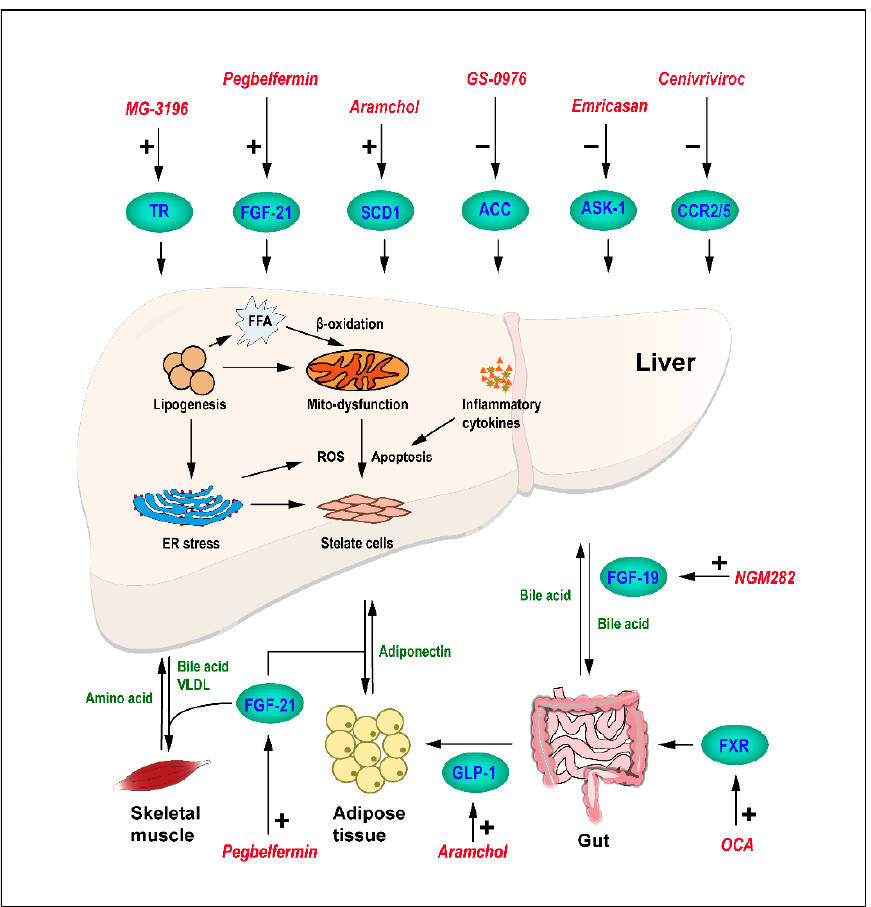
Figure 1. Representative therapeutic methods in the complex pathophysiology of NASH, which involved a variety of organs, tissues, and cells. Signals marked in green are protective against NASH, and those marked in red are current clinical trial drugs that ameliorated NASH as agonists/inhibi- tors (+/ − ) of various receptors marked in blue. Abbreviations: TR, thyroid hormone receptor; FGF, fibroblast growth factor; SCD1, stearoyl-CoA desaturase; ACC, acetyl-CoA carboxylase; ASK1, apoptosis signaling kinase 1; GLP-1, glucagon-like peptide 1; FXR, farnesoid X nuclear receptor; FFA, free fatty acids; and ROS, reactive oxygen species.